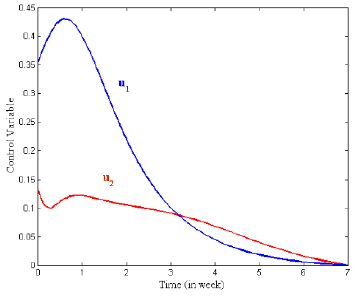
Figure 4. Variation in control variables with time